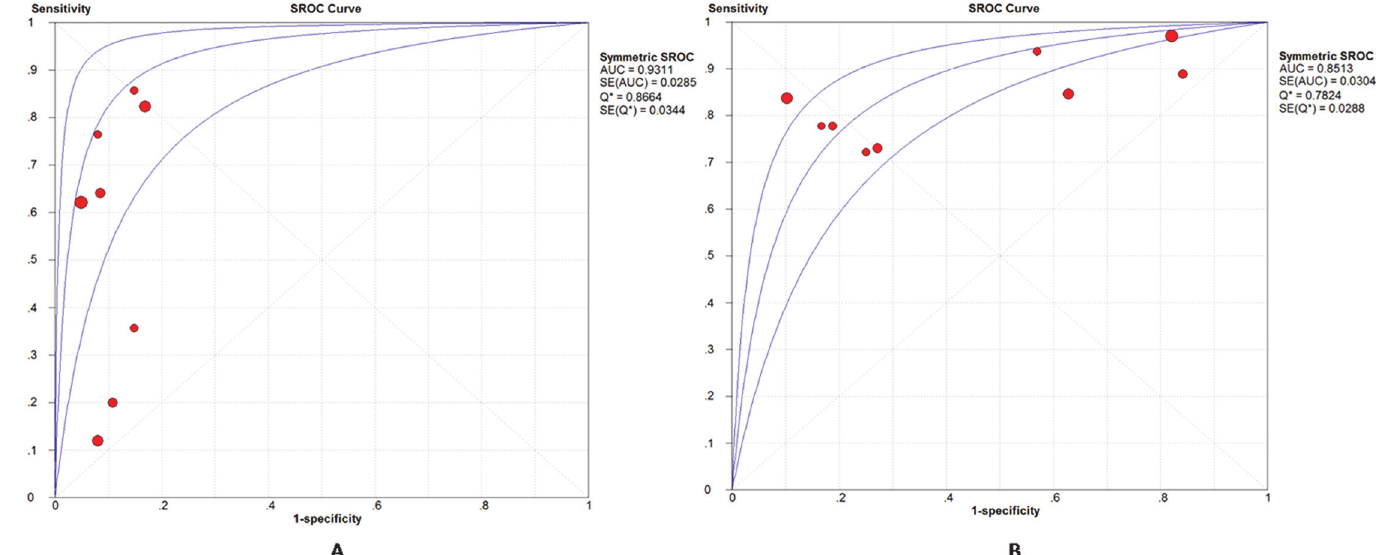
Fig 5. Summary receiver operating characteristic (SROC) curves for DWI in predicting w-HCC and p-HCC. (A) SROC curve for the prediction of w- HCC. (B) SROC curve for the prediction of p-HCC. The AUC was 0.9311 and 0.8513 according to SROC curves, indicating an excellent and moderately high diagnostic accuracy for the prediction of w-HCC and p-HCC,